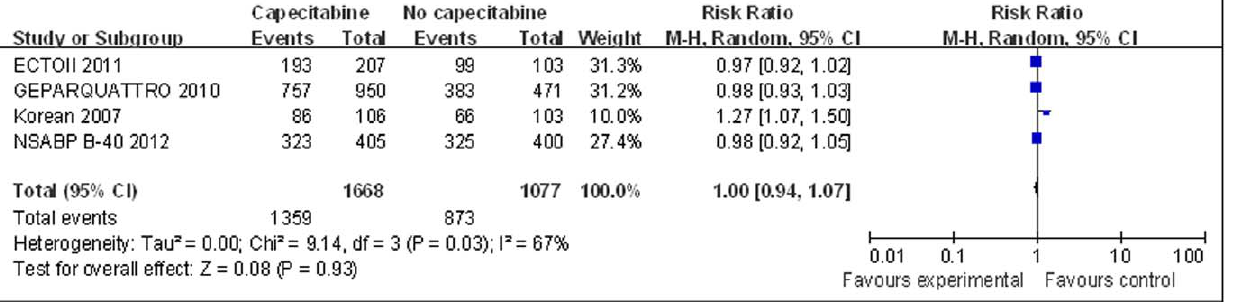
Figure 4. Forest plot to meta-analyze ORR for neoadjuvant therapy with or without capecitabine.